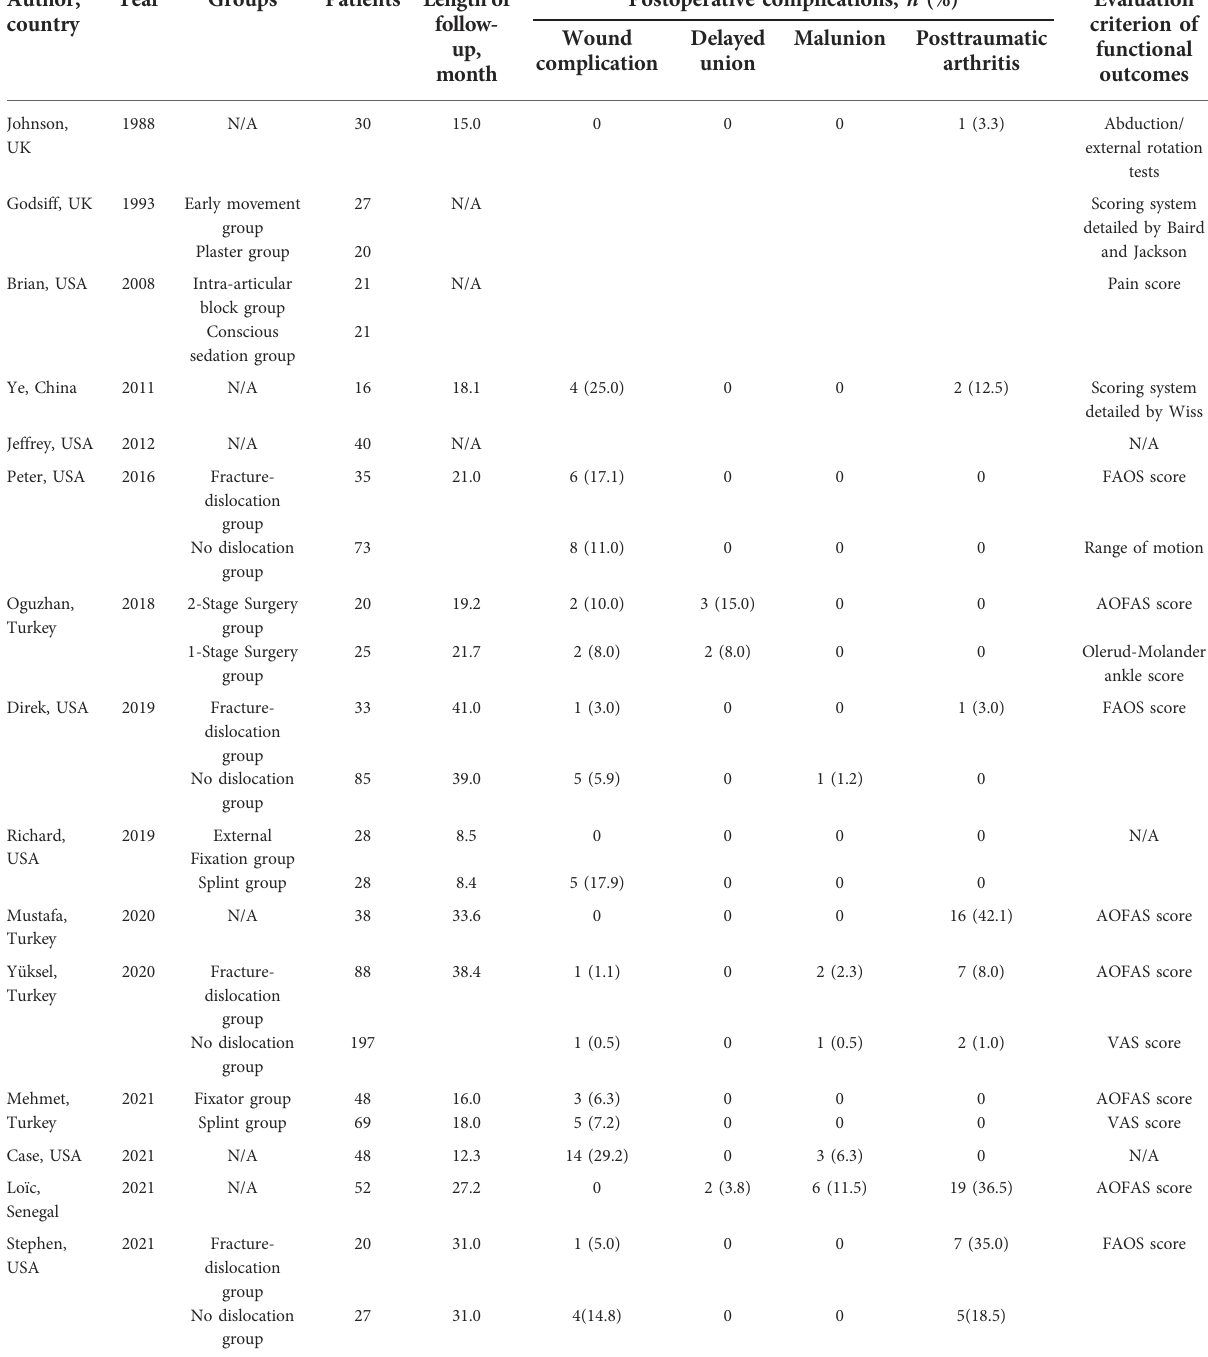
TABLE 4 Clinical outcomes of the 15 included